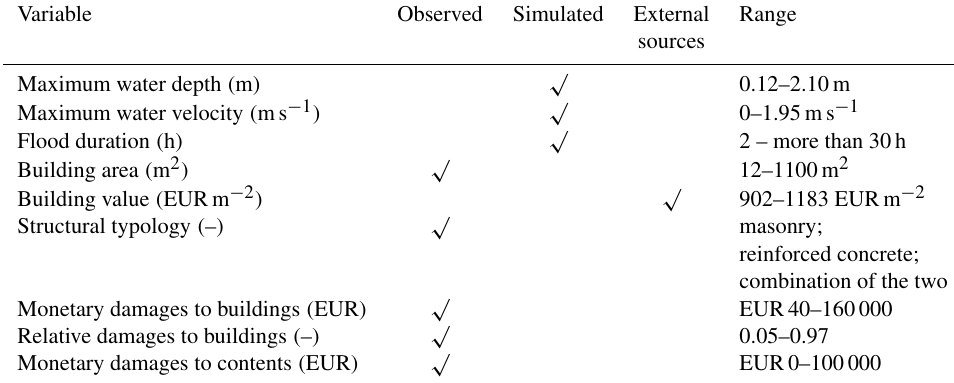
Table 3. Considered variables and their sources and ranges, for building and content damage analysis. Variable Observed